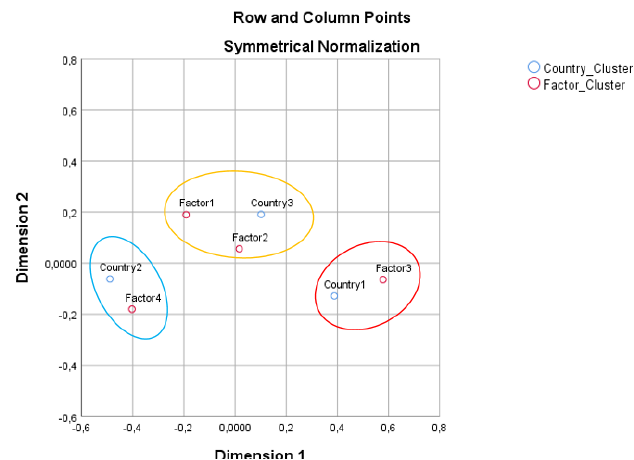
Fig. 1 – Symmetric correspondence map. Source: own